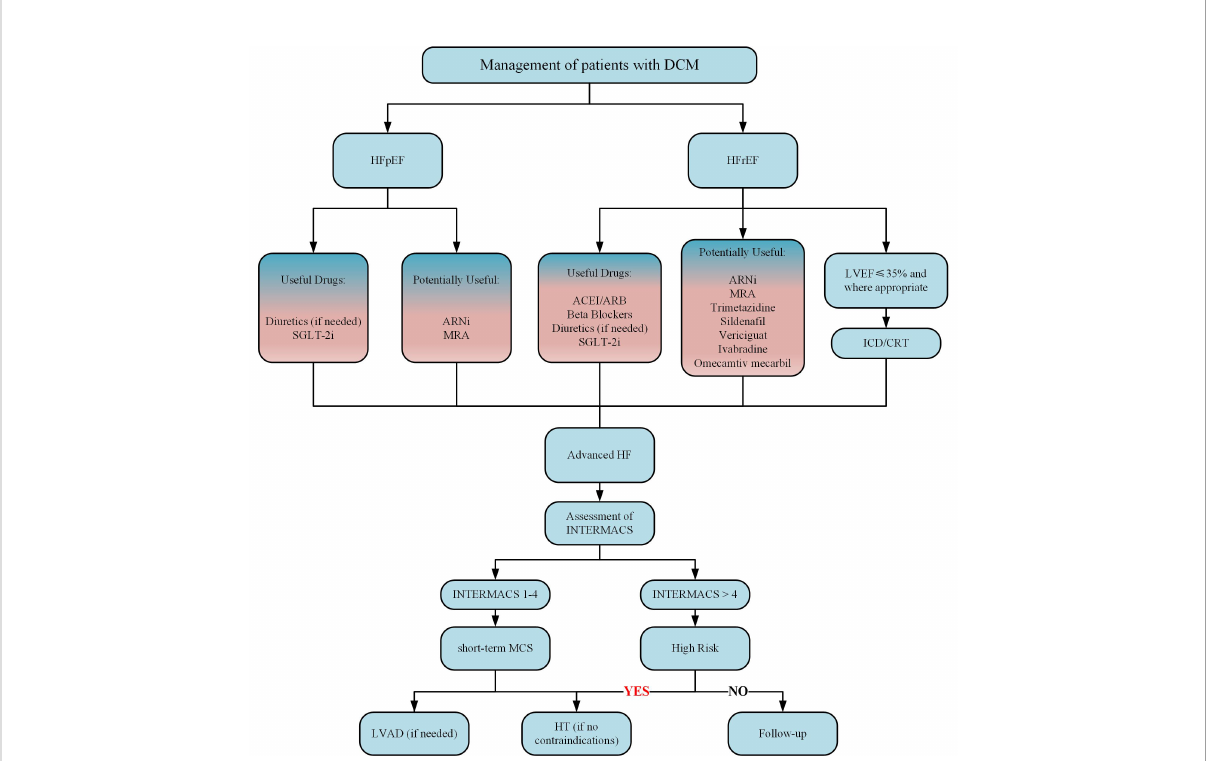
FIGURE 3 Treatment algorithm of DCM. ACEI, indicates angiotensin-converting enzyme inhibitor; ARB, angiotensin receptor blocker; ARNi, angiotensin receptor-neprilysin inhibitor; CRT, cardiac resynchronization therapy; HF, heart failure; HFrEF, heart failure with reduced ejection fraction; HFpEF, heart failure with preserved ejection fraction; HT, heart transplant; ICD, implantable cardioverter-de fi brillator; INTERMACS, Interagency Registry for Mechanically Assisted Circulatory Support; LVAD, left ventricular assist device; MCS, mechanical circulatory support; MRA, mineralocorticoid receptor antagonist; SGLT2i, sodium-glucose cotransporter 2